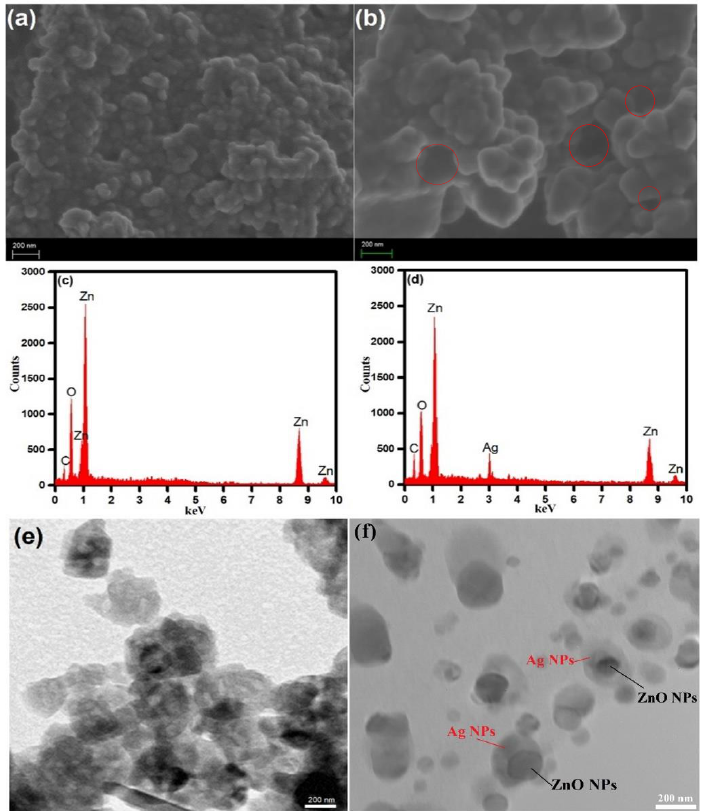
Figure 7. SEM images ( a ) ZnO NPs, ( b ) ZnO–Ag nanocomposite, EDX spectrum ( c ) ZnO NPs, ( d ) ZnO–Ag nanocomposite, and TEM images of ( e ) ZnO NPs and ( f ) ZnO–Ag